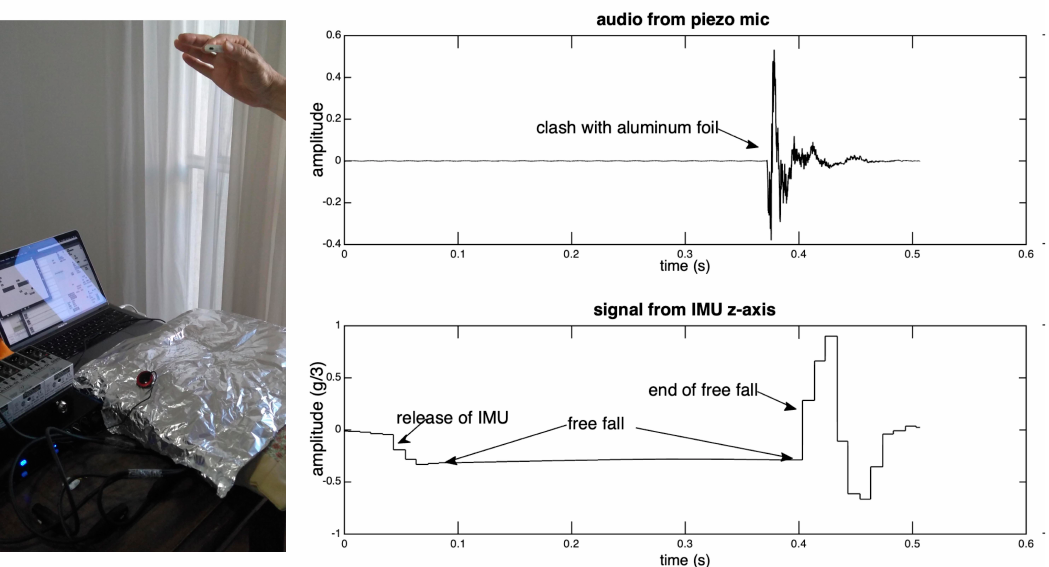
Figure 3. Measurement of the IMU response delay. On the left, preparation for the free fall. On the right, two-channel recording with audio and sensor